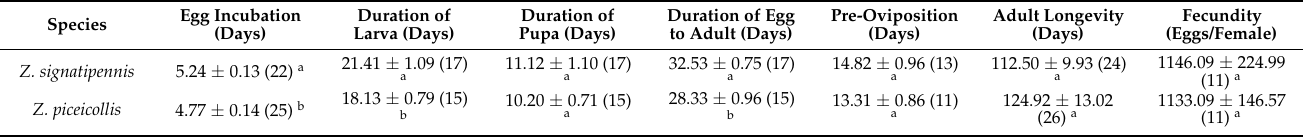
Table 2. Means ± SE (n) 1 of the different life history parameters of Zygogramma signatipennis and Z. piceicollis reared on Tithonia rotundifolia